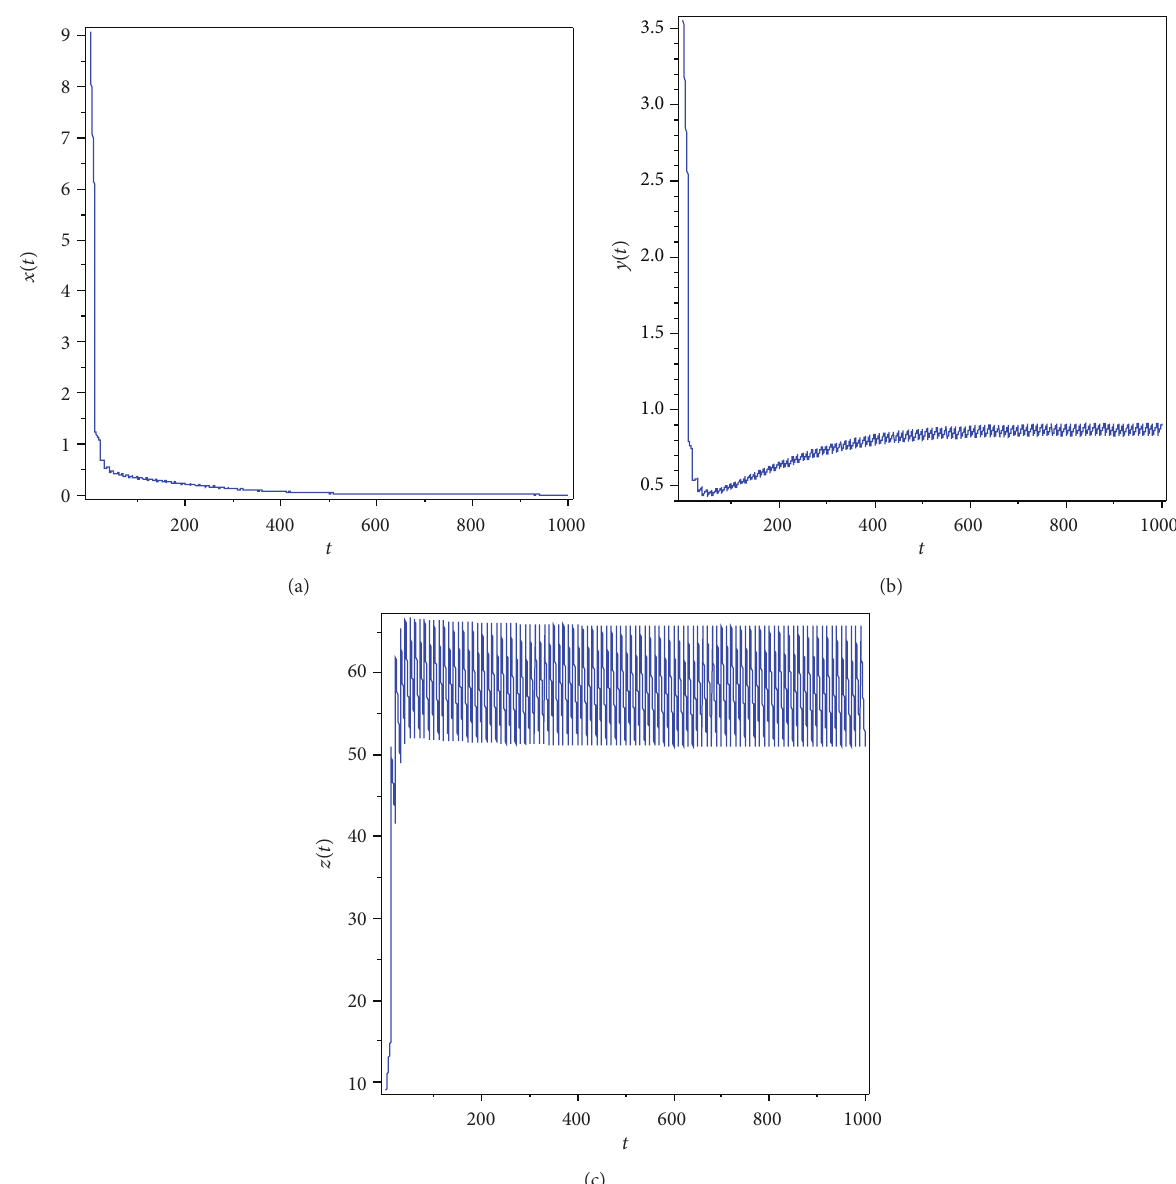
Figure 4: Time series of a solution of model (6) with 𝑞 = 60 : (a) time series of the prey population 𝑥(𝑡) ; (b) time series of the prey population 𝑦(𝑡) ; (c) time series of the predator population 𝑧(𝑡)